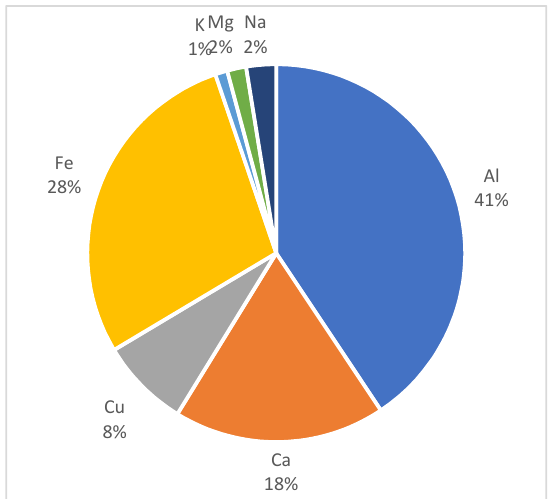
Figure 4. Composition ratio of metal particles discharged from incineration experiment of waste mulching LDPE.